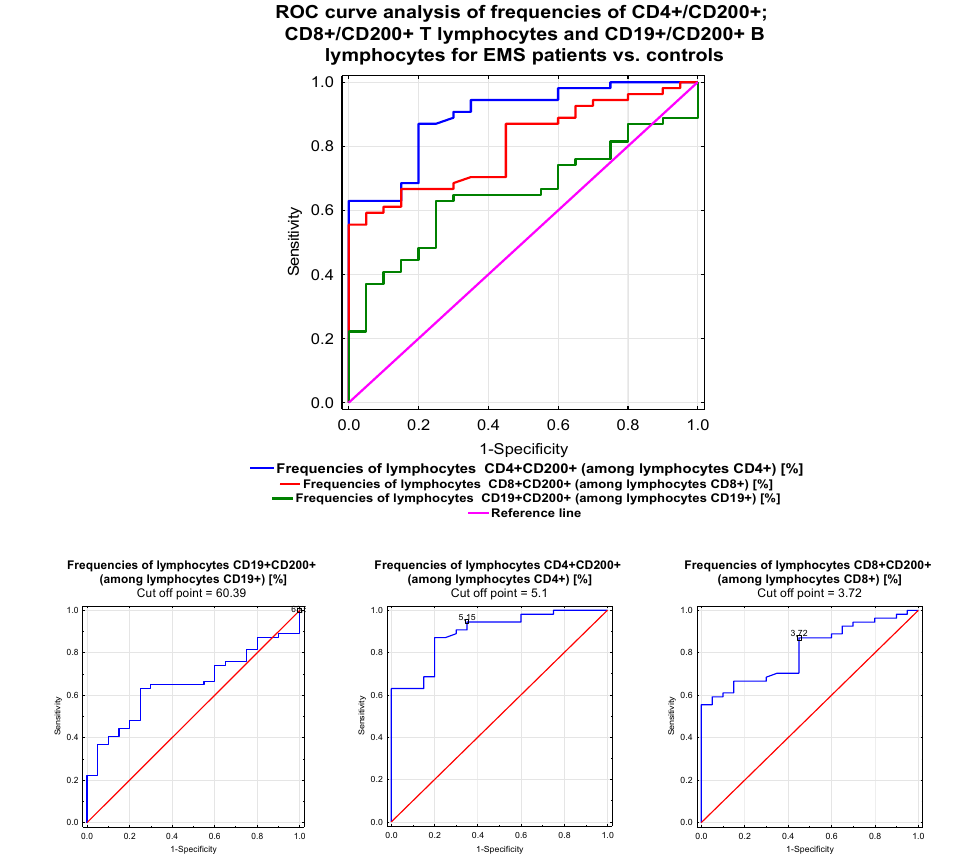
* DeLong test for comparison with no e ff ect (AUC = 0.500).